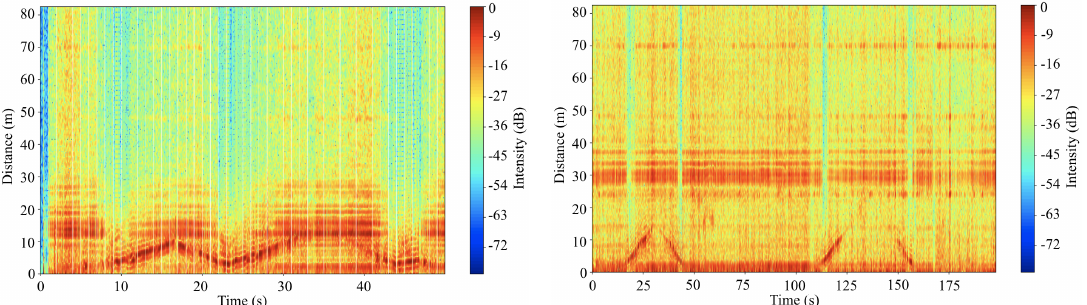
Figure 11. Distance measurement of a person at the main floor of the building ( left ) and in front of the building ( right